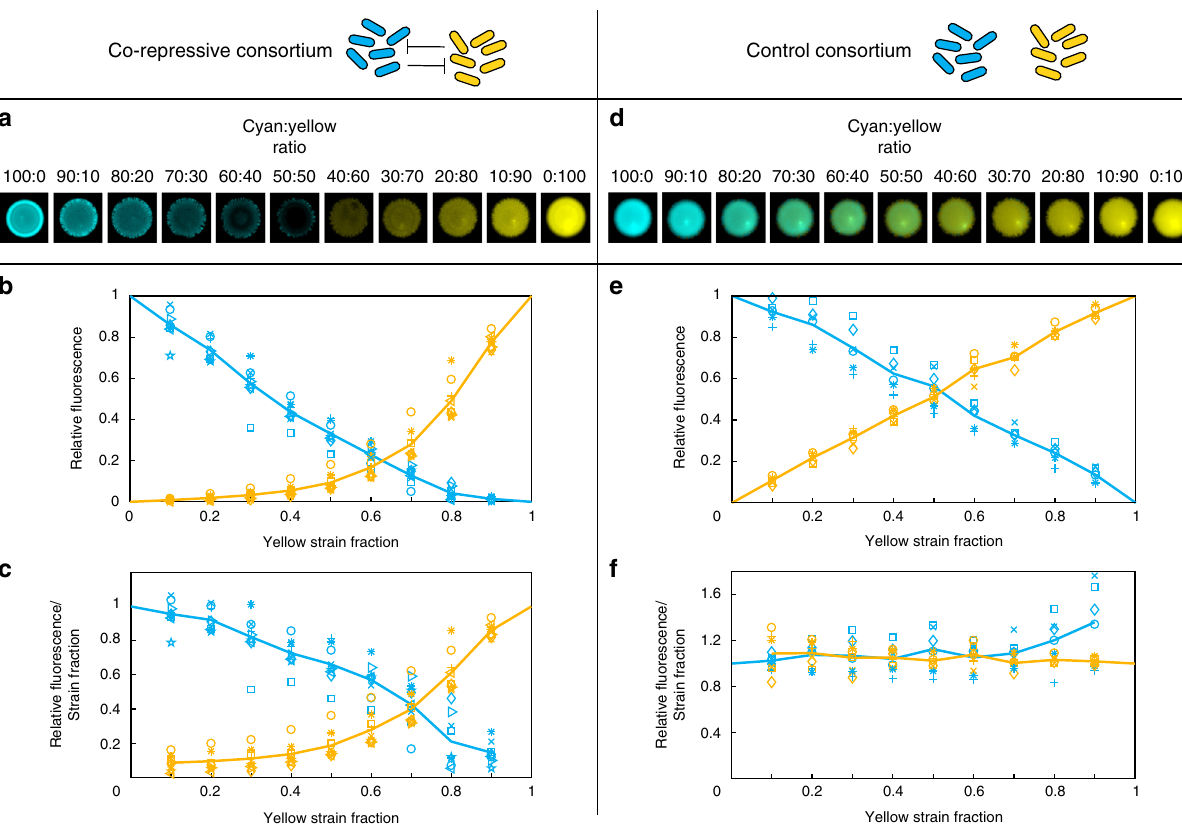
Fig. 2 Majority wins pattern. a Fluorescence images of spots of the co-repressive consortium on agar plates at mixtures of the two strains with 10% increments from 100% cyan strain to 100% yellow strain. b Fluorescence intensity of the co-repressive consortium at mixtures in liquid cultures in a 96- well plate ( n = 9). Results were obtained using 10% increments starting with 100% cyan strain and ending with 100% yellow strain. To compare fl uorescence intensities with a maximum, they are normalized to the values measured in wells containing a single strain of the respective color (100% wells). Fluorescence intensity correlates with strain fraction in a majority wins pattern. Same symbols with different colors represents the yellow and cyan intensities from the same well of the same replicate experiment and lines represent averages across all replicates (consistent throughout all graphs presented). c The data from ( b ) normalized to strain fraction to account for any change in fl uorescence due to the decrease in the number of cells containing the fl uorescence gene. The co-repressive consortium still follows a majority wins pattern even after normalization to strain fraction suggesting active shut off of the minority strain. d – f Same as ( a – c ) but for a control consortium lacking intercellular signaling and with constitutive expression of sfcfp or sfyfp in the respective strains ( n = 6). The control consortium does not follow a majority wins pattern after normalization to strain fraction. Source data are provided as a Source Data fi